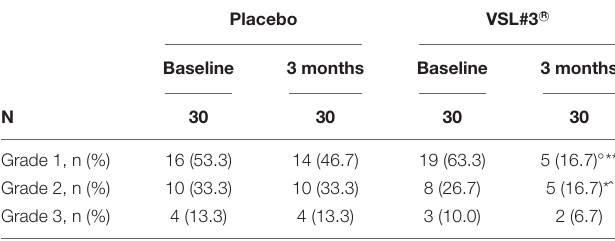
TABLE 3 | Grade of fatty liver during VSL#3 R (cid:13) treatment at baseline and after 3 months.